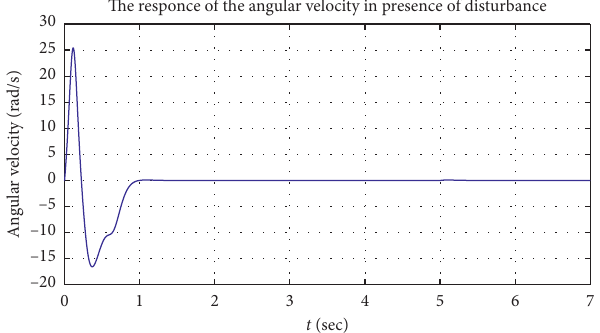
Figure 2: Response of the state variable x